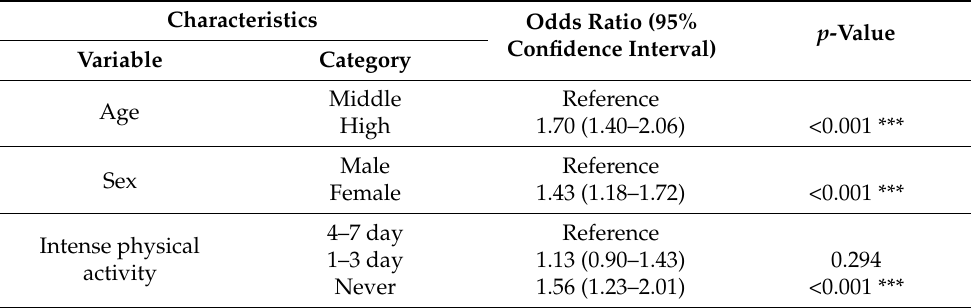
Table 2. Odds ratio (95% confidence interval) for vitamin D level and baseline